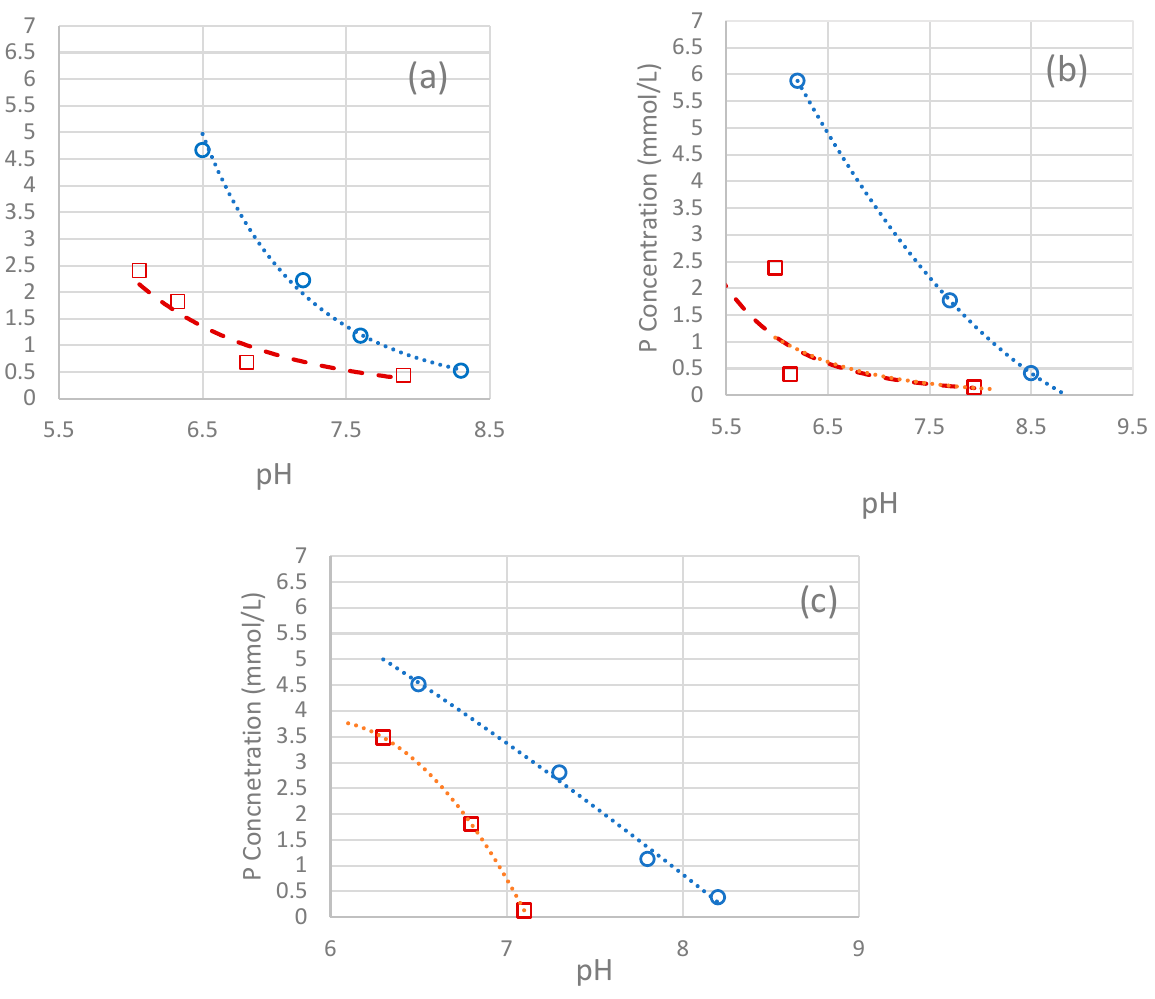
Figure 3. Metastable zones for the CaCl 2 -NaH 2 PO 4 -NaOH system at ( a ) (22 ± 1) °C and ( b ) (40 ± 1) °C and ( c ) CaCl 2 -NaH 2 PO 4 -NaF system at (22 ± 1) °C.